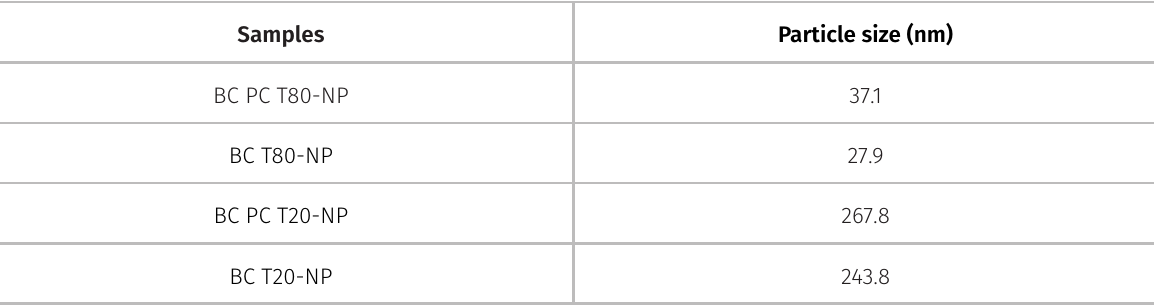
Figure 5. Variation of the particle size (main peak) of the colloidal mucin system (250 μg/ml) as a function of the addition of different concentrations of pectin-coated nanoparticles (BC PC T20-NP) (a). Cytotoxic effect of free β-carotene (CC= cell control) (b), BC PC T80-NP (black bars) and Blank PC T80-NP (gray bars) (c), and BC PC T20-NP (black bars) and Blank PC T20-NP (gray bars) (d) on Caco-2 cell lines after 6h incubation. Data are represented by mean ± standard deviation (n = 3). Distinct symbols (* and #) indicate statistical differences between treatments and the Table V. Particle size of dispersions containing mucin and uncoated (BC PC T80-NP and BC T80-NP 2.5%, v/v) and